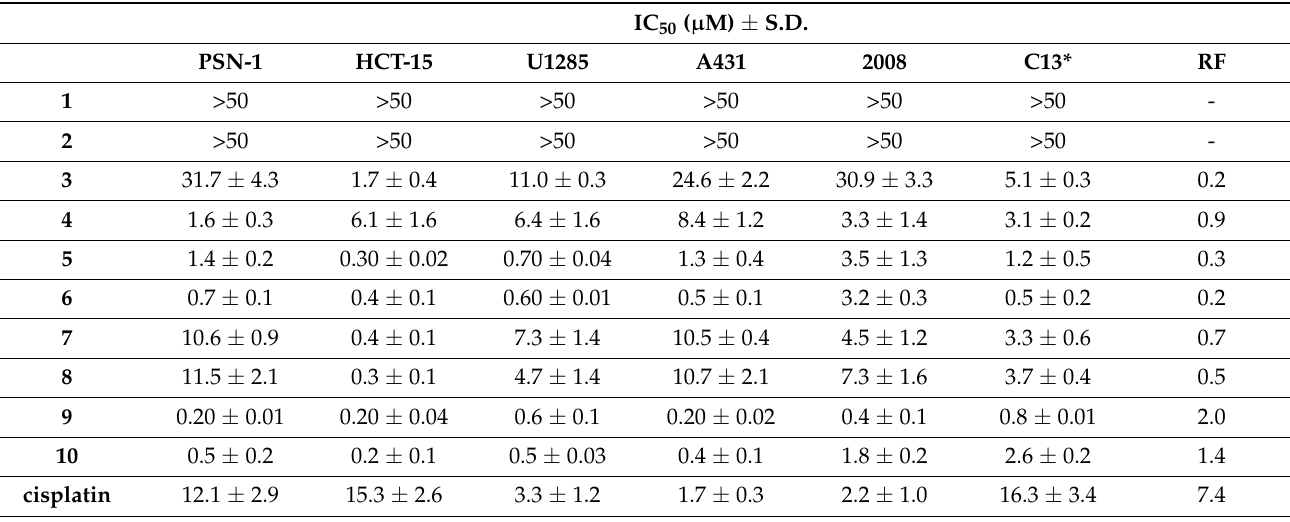
Table 3. Cytotoxicity of ligands 1 – 2 , newly developed copper complexes 3 – 10 , and cisplatin on 2D cell